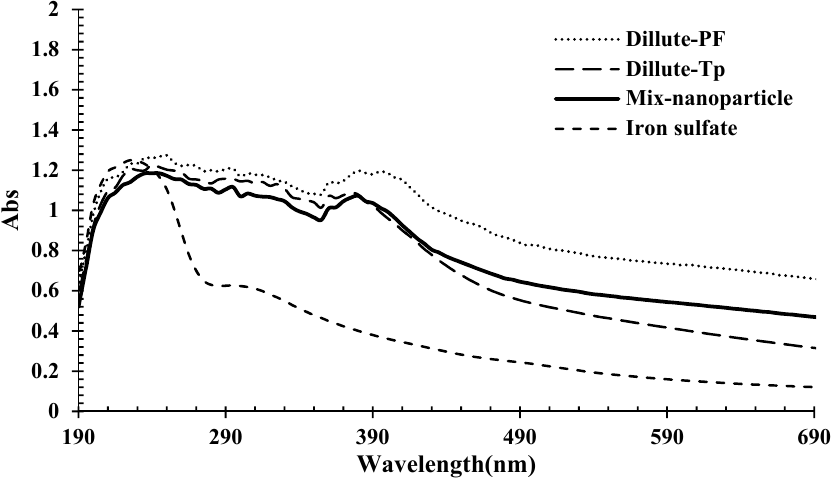
Figure 1. UV-Vis spectra related to the plant extracts, iron solution, and the synthesized nanoparticles.